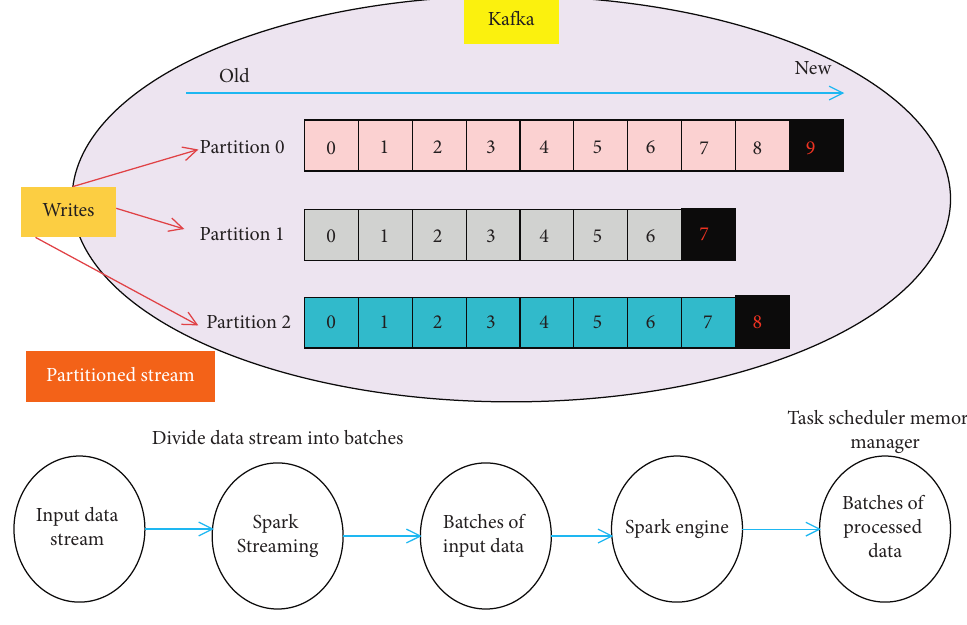
Figure 3: Schematic diagram of Samza streaming processing.